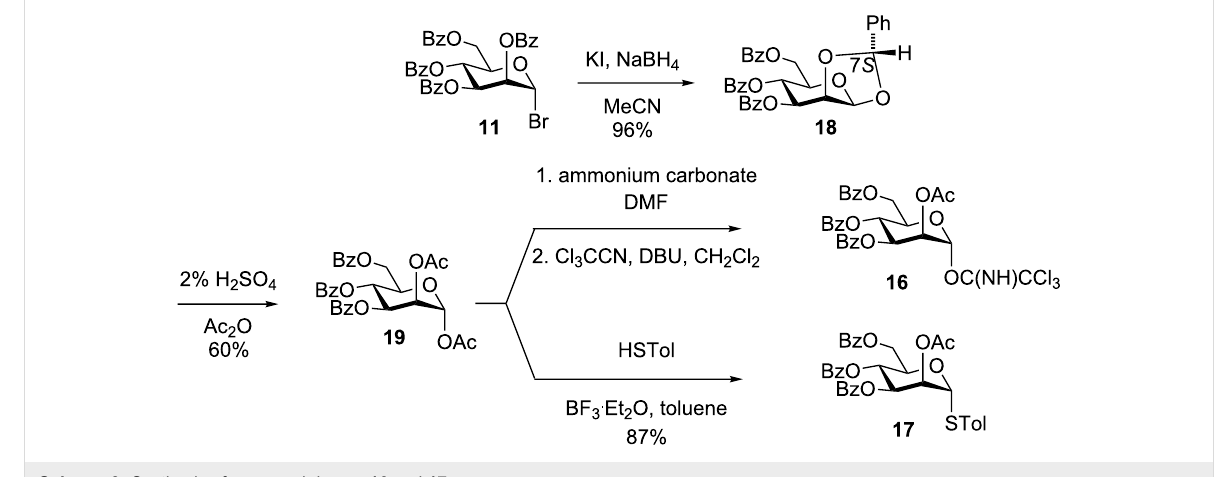
Scheme 3: Synthesis of mannosyl donors 16 and 17 .